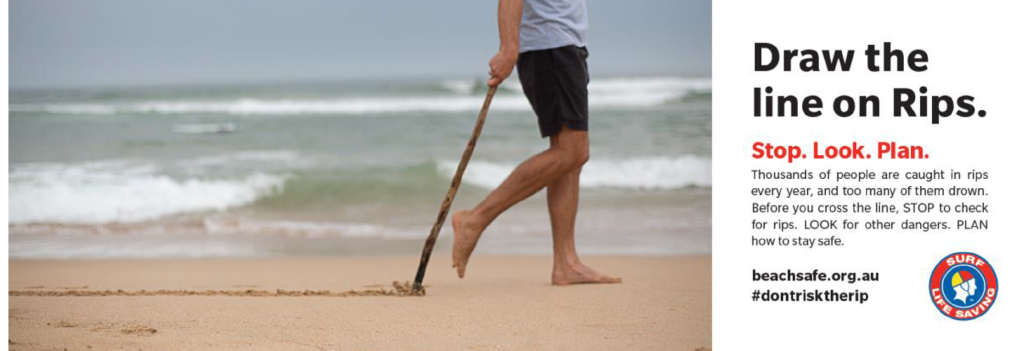
Figure 7. Core graphic of the Surf Life Saving Australia “Think Line Campaign” (SLSA, 2021).